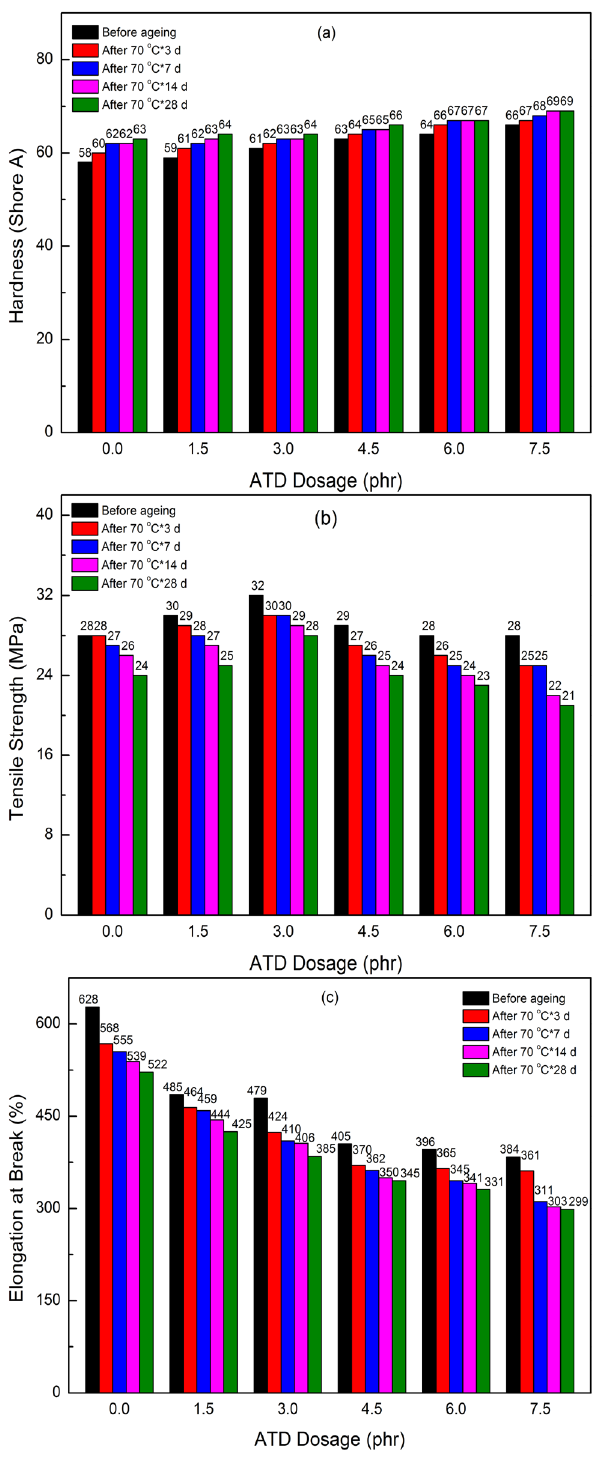
Figure 3: Variation of ( a ) hardness ( Shore A ) , ( b ) tensile strength ( MPa ) , and ( c ) elongation at break ( % ) with ATD dosage after accelerated aging at 70°C for di ff erent aging time for modi fi ed IR/silica/CB